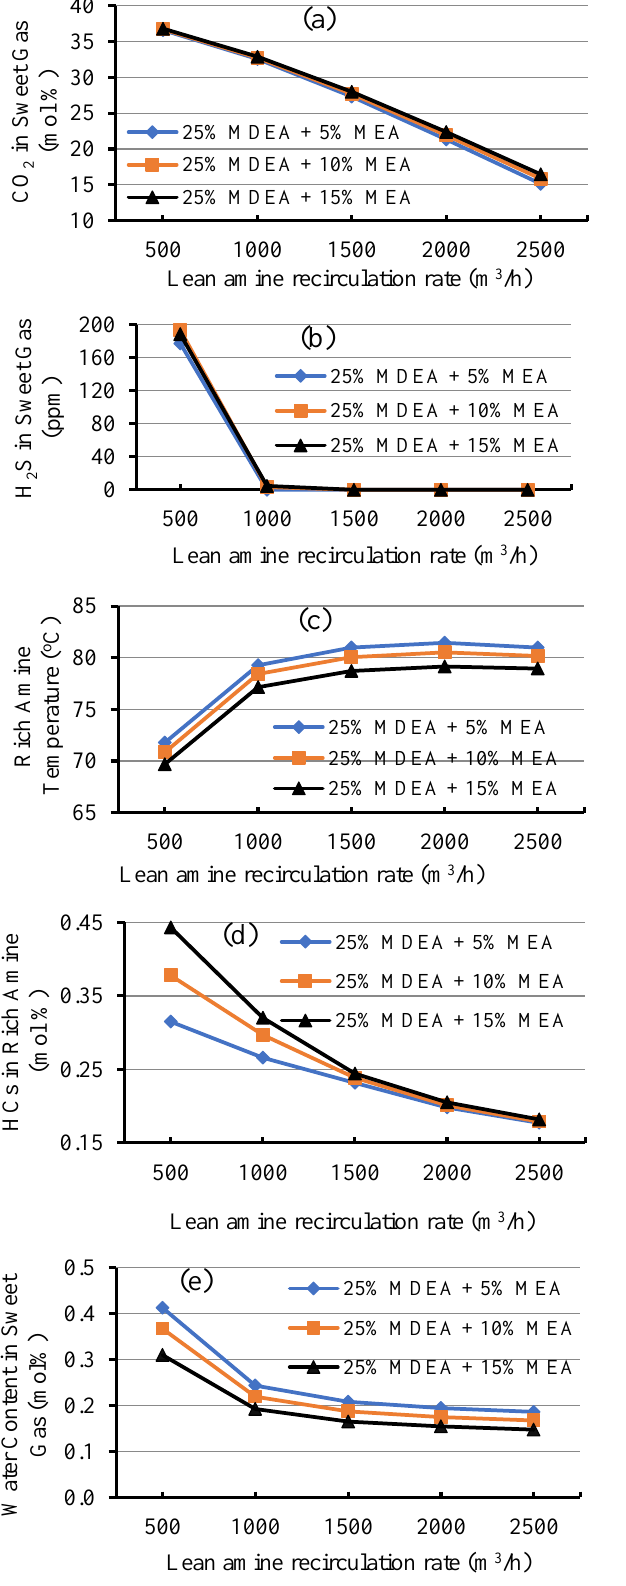
Fig. 6. Amine absorber performance with increasing recirculation rate with 40 mol% MDEA and 5-10-15 mol% DEA in aqueous solution at pressure drop of 34 kPa